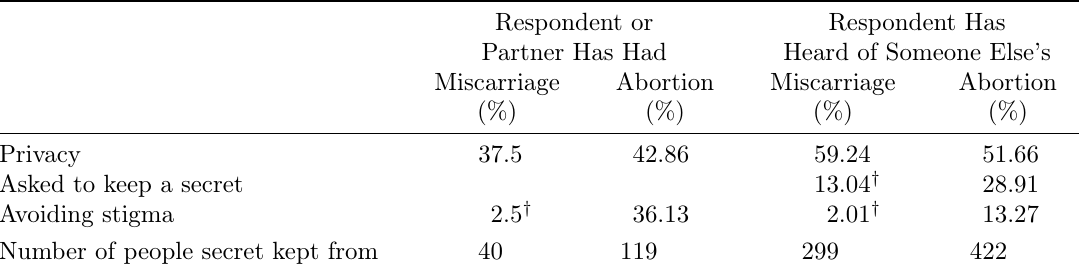
Table 4: Frequency of Why Secrets are Kept, AMACS 2012